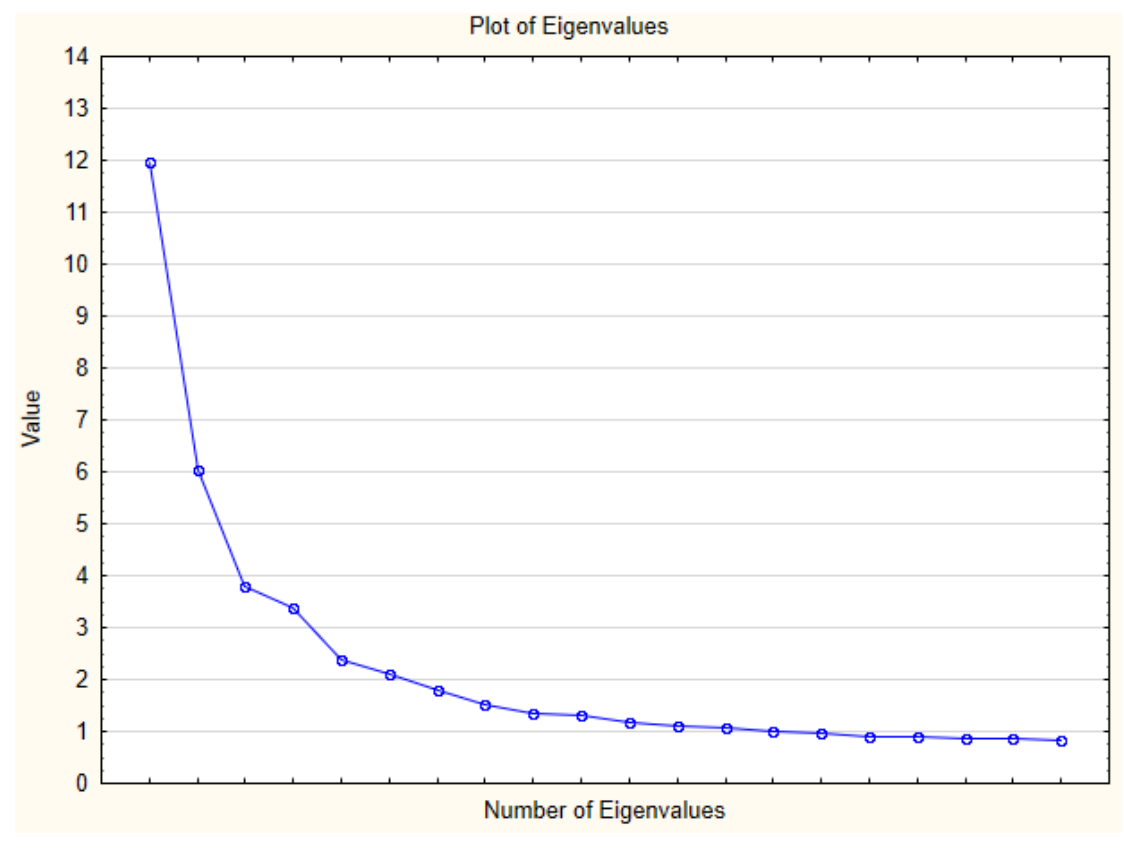
Figure 1. Plot of Eigenvalues of factors identifies in the MBRSQ-PL questionnaire. Table 2. Exploratory factor analysis of the MBSRQ-PL